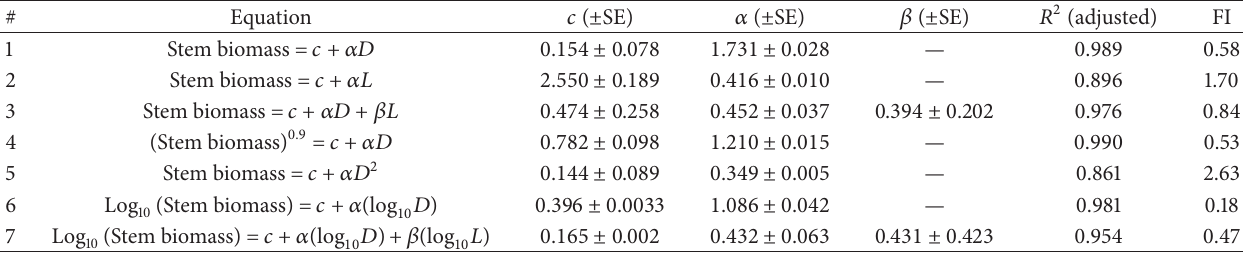
Table 4: Allometric equations of mixed species for estimating liana stem biomass (kg).